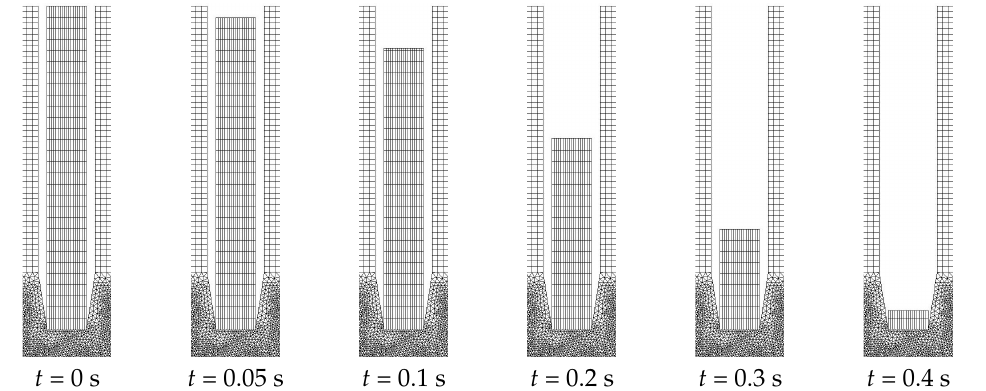
Figure 3. Dynamic mesh status in zone